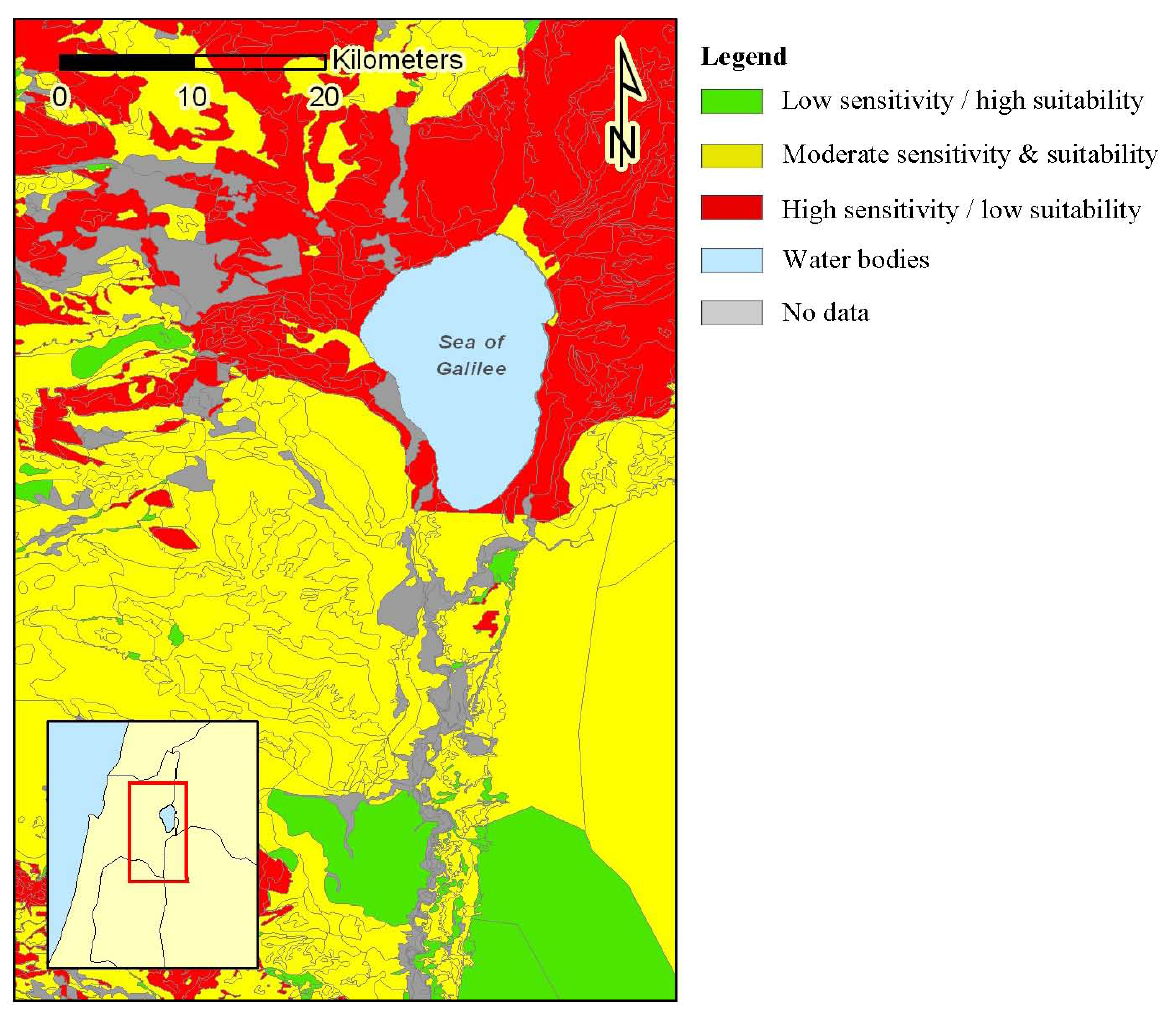
Figure 8. Cut-out of the assessment map visualizing the aggregated total sensitivity (scale 1: